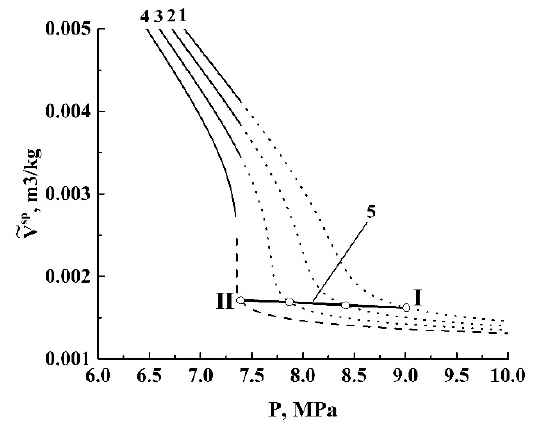
Figure 8. Recovery of a fragment of the adiabatic curve (5) for CO 2 from the isothermal data (1–4); 1— T = 310 K; 2— T = 308 K; 3— T = 306 K; 4— T = 304 K. V sp is the specific volume. (cid:101) S s = 1.354 kJ / kg · K. Solid lines—gas; dotted lines—supercritical fluid; dashed line—liquid.